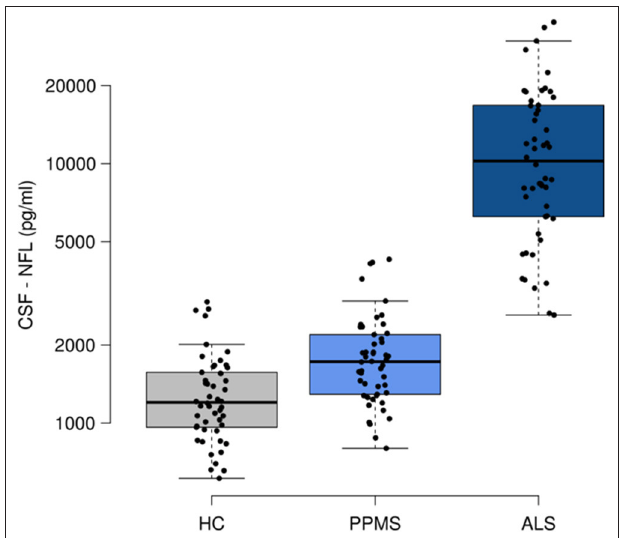
FIGURE 1 | Neurofilament light (NFL) in cerebrospinal fluid (CSF). ALS, amyotrophic lateral sclerosis; HC, healthy controls; PPMS, primary progressive multiple sclerosis. Boxes indicates the interquartile range, bars indicates median CSF-NFL values, and whiskers present the 95% Cl. The dots present the individual values. Group comparisons were conducted using a Kruskai-Wallis one-way analysis of variance with post-hoc Dunn-Bonferroni-testing. P -values < 0.05 were deemed to be statistically significant. PPMS and ALS patients showed higher CSF-NFL levels than HC, while ALS had higher NFL values than